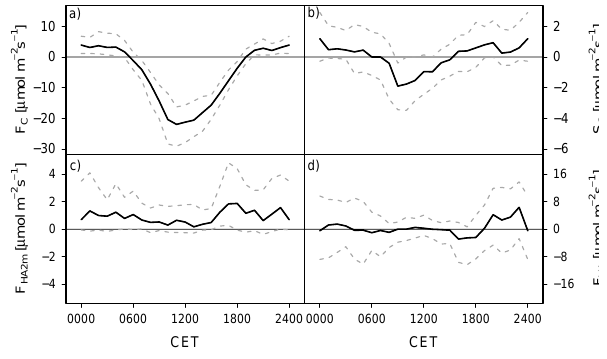
Fig. 7. Diurnal cycles of (a) CO 2 flux F C , (b) storage term S C , (c) horizontal advection F HA2m and (d) vertical advection F VA for the period of May to August 2007. Black lines indicate median val- ues, grey broken lines inter quantiles (25%, 75%) of the respective fluxes. Note that y axes are different